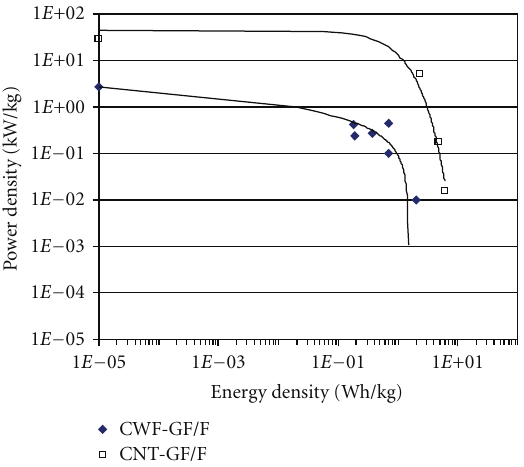
Figure 12: Ragone plots of two types of EDLC supercapacitors (full cells): the CWF-GF/F supercapacitor cell and the CNT-GF/F supercapacitor